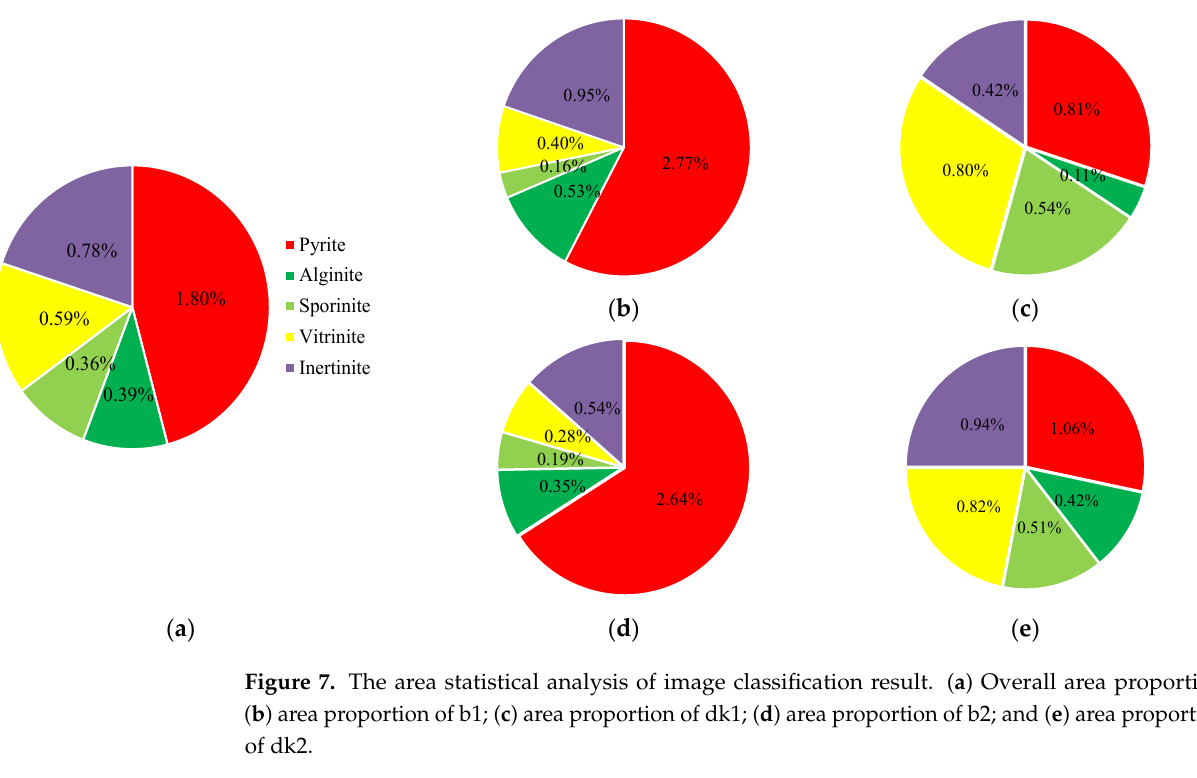
Figure 6. Image classification result and the area percentage content of each classification.